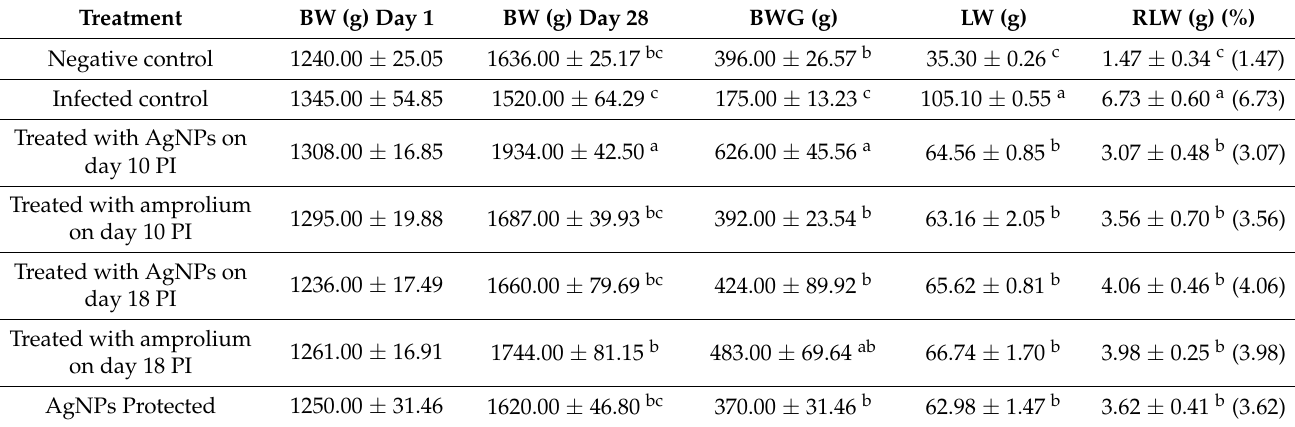
Table 4. Effects of the different treatments on the mean body weight (BW), body weight gain (BWG), liver weight (LW), and relative liver weight (RLW) of the normal, infected, and treated